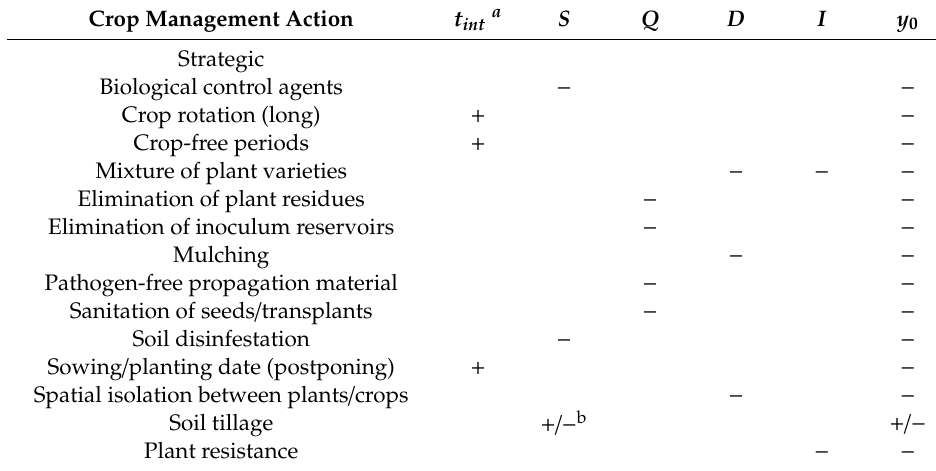
a Symbols are listed in Table 1, b +/ − = the e ff ect depends on the